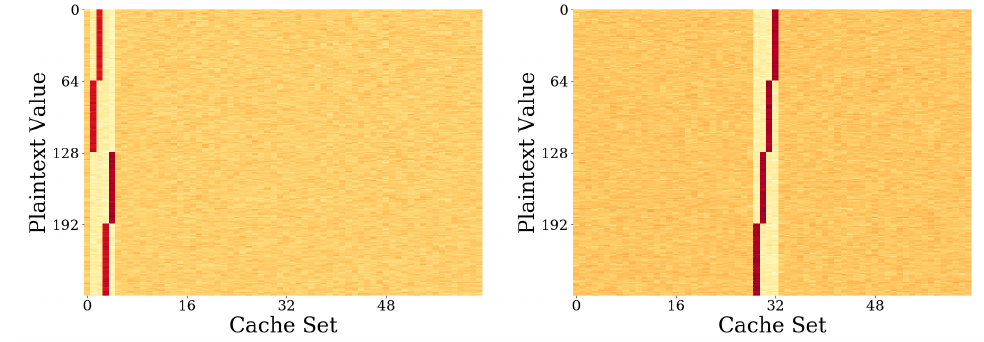
Figure 5: Results of the synchronous Prime+Probe attack on the first round, targeting the byte [0 , 0] (left) and [1 , 3] (right). Bytes [0 , 0] (left) and [1 , 3] (right) of the first round attack. The two MSBs of RK 0 [0 , 0] (resp. RK 0 [1 , 3]) are 01 (resp.